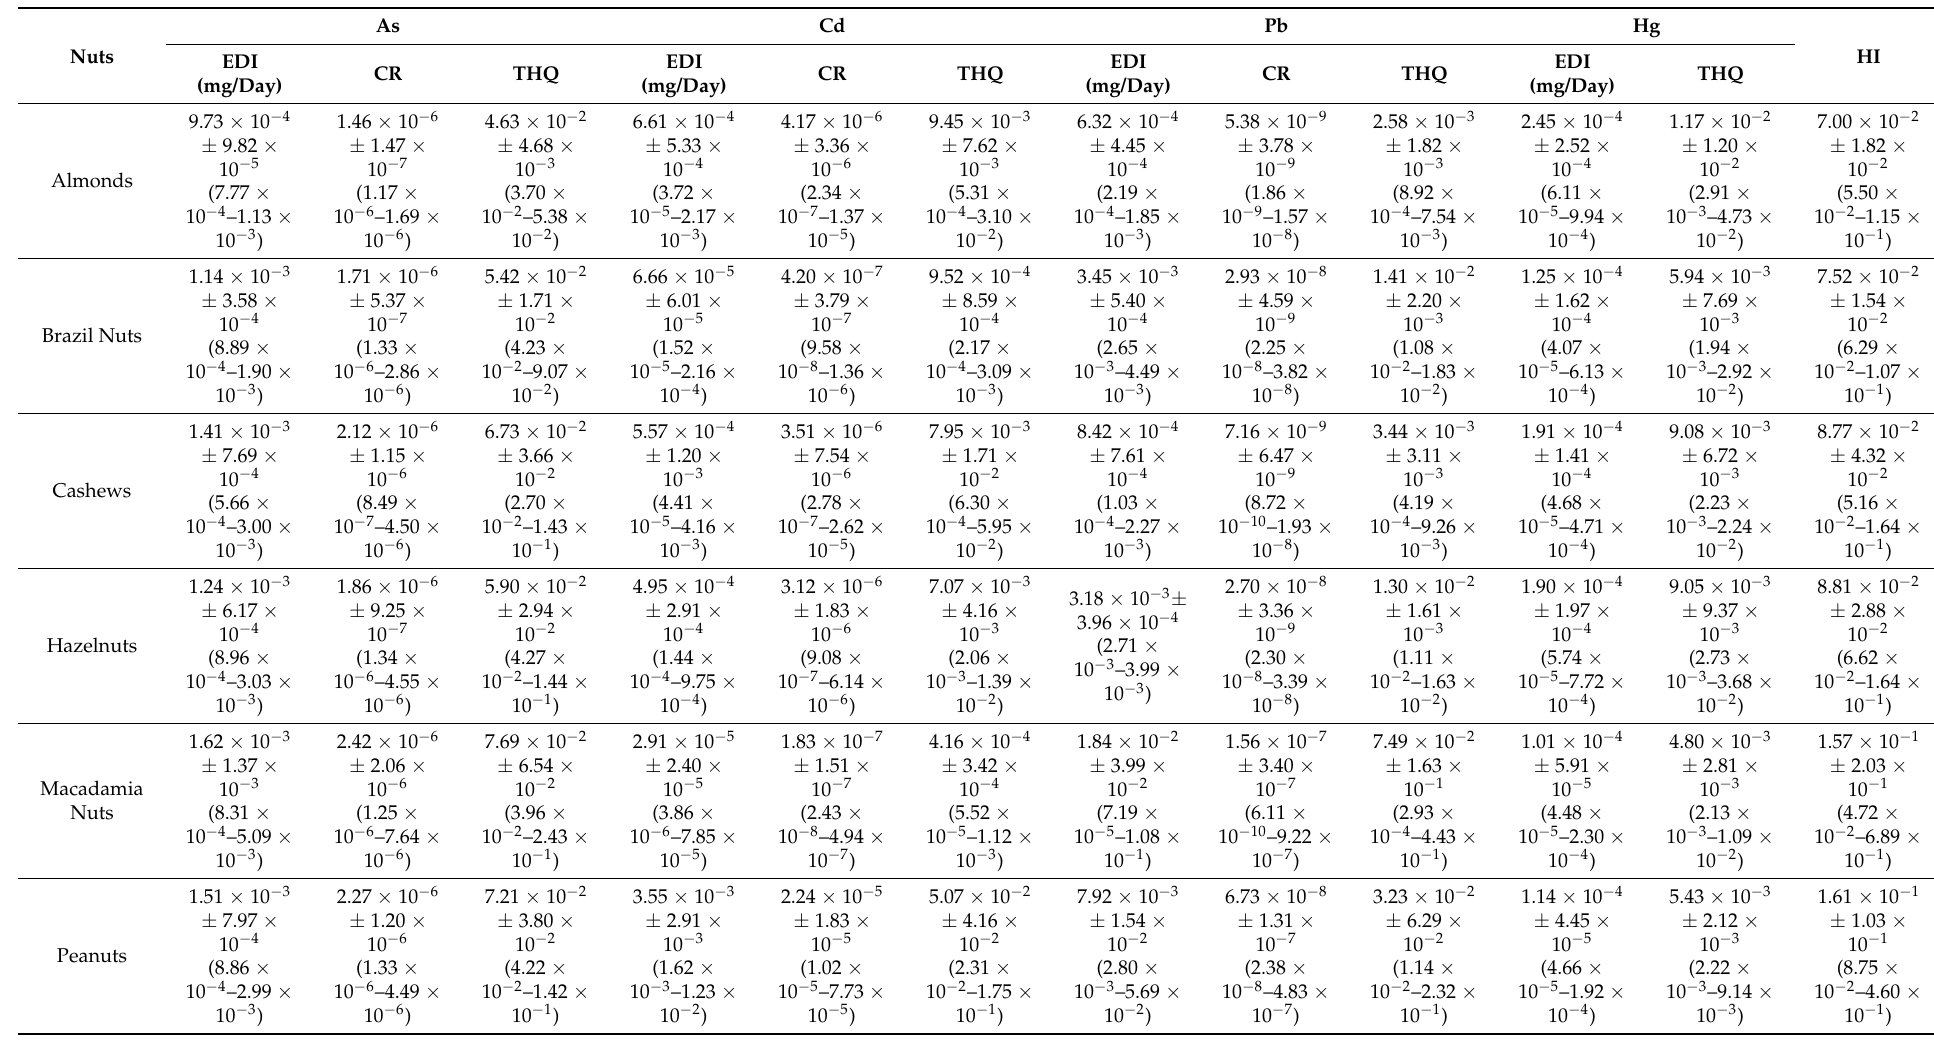
Table 3. Estimated human health risk calculated for toxic elements (Hg, Pb, Cd and As) through consumption of selected species of